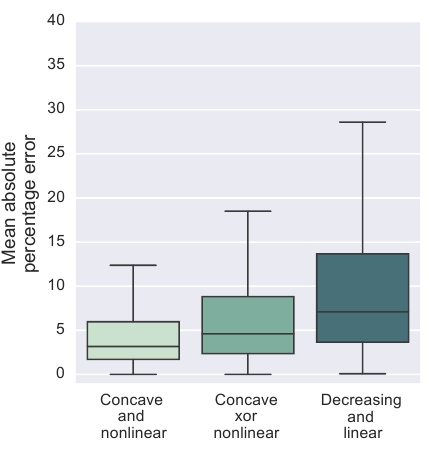
Figure 6. Mean absolute percentage error (MAPE) lumped across catchments by three groups: concave only recessions with nonlinear fitting; concave recessions or nonlinear fitting but not both (denoted using the logical “exclusive or” operator, “xor”); and decreasing re- cessions (without the concavity requirement) and linear fitting pro- cedures.